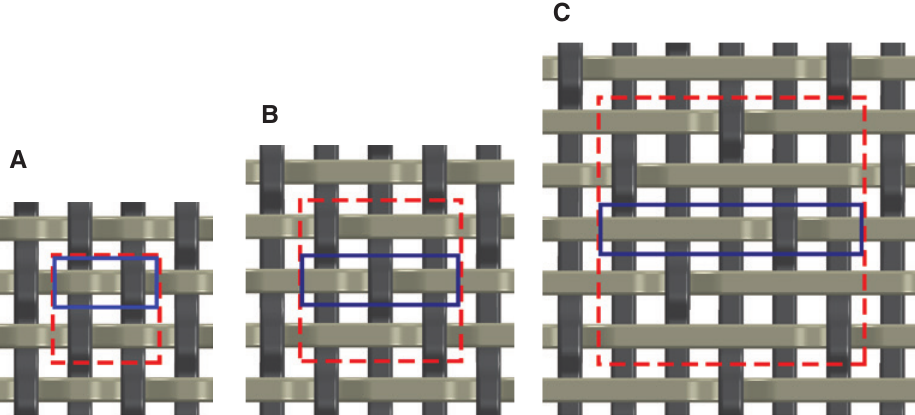
Figure 18: Woven fabrics with their RUC (in dashed line box) and ORUC (in solid line